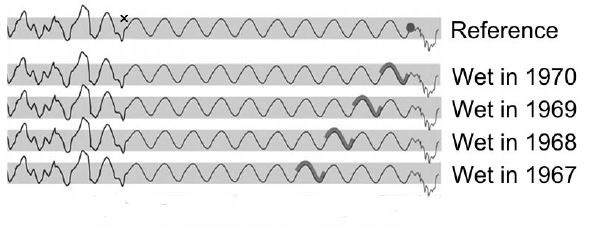
Fig. 6. Climate forcing sequences for estimating persistence in the coupled system. Irregular pattern denotes unaltered climate forcing (left, and right). At the “x” starts the cyclic median climate forcing. The grey ∼ on top of the regular wave symbolizes a wet anomaly. The grey dot is symbol for the year